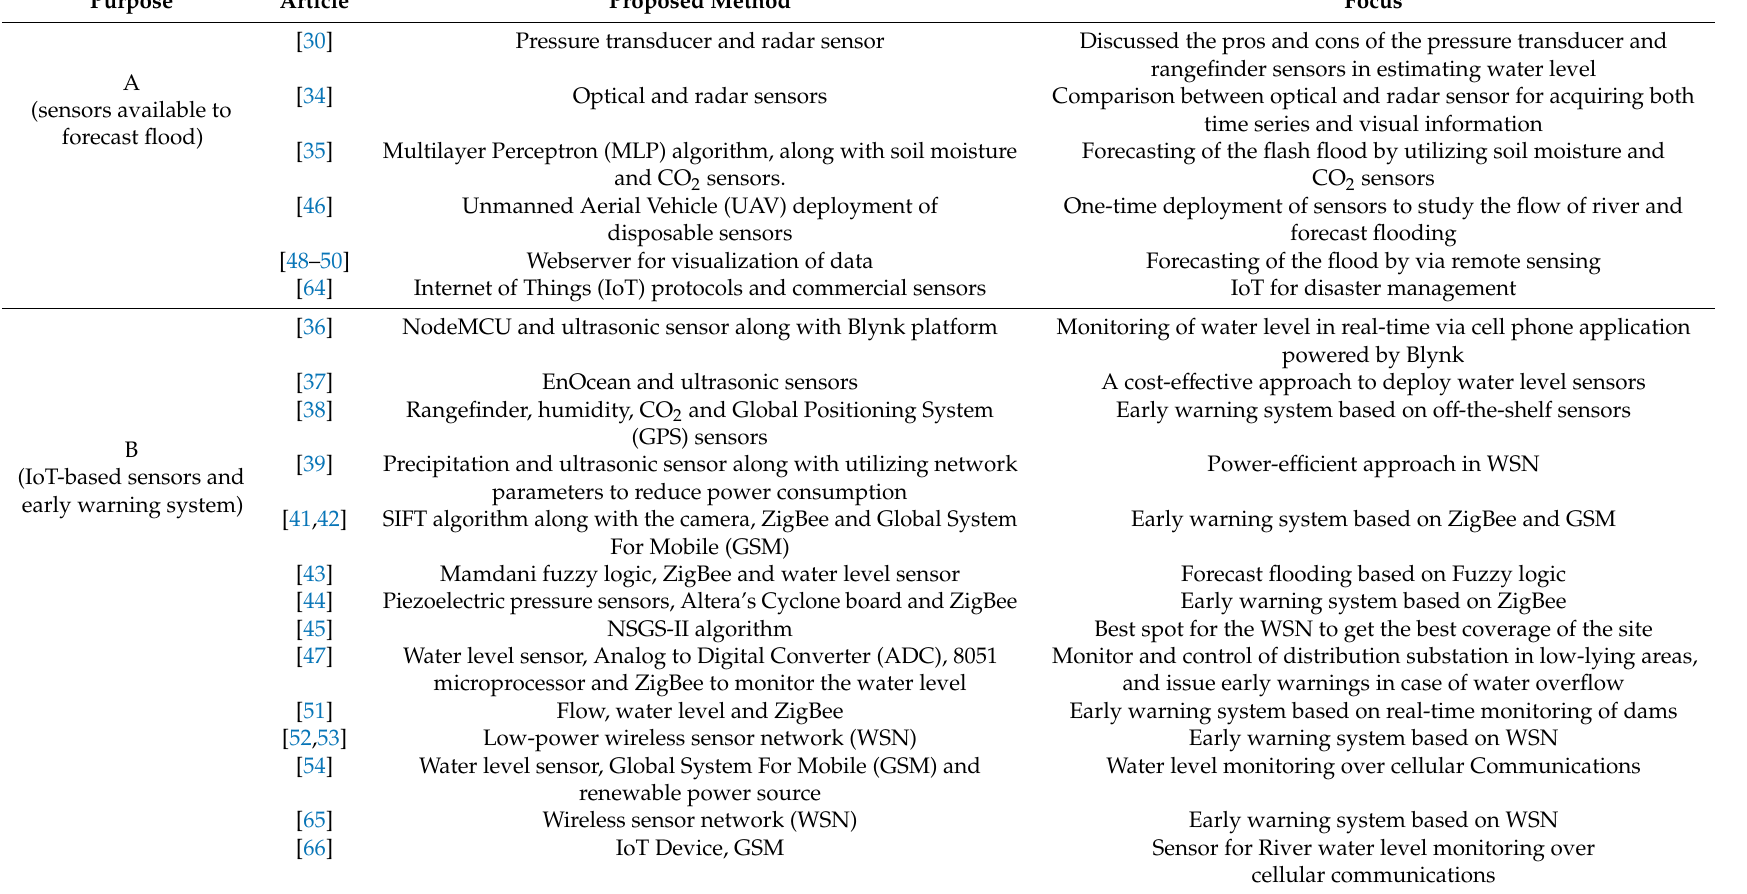
Table 3. Analysis of IoT-based sensors cited in the